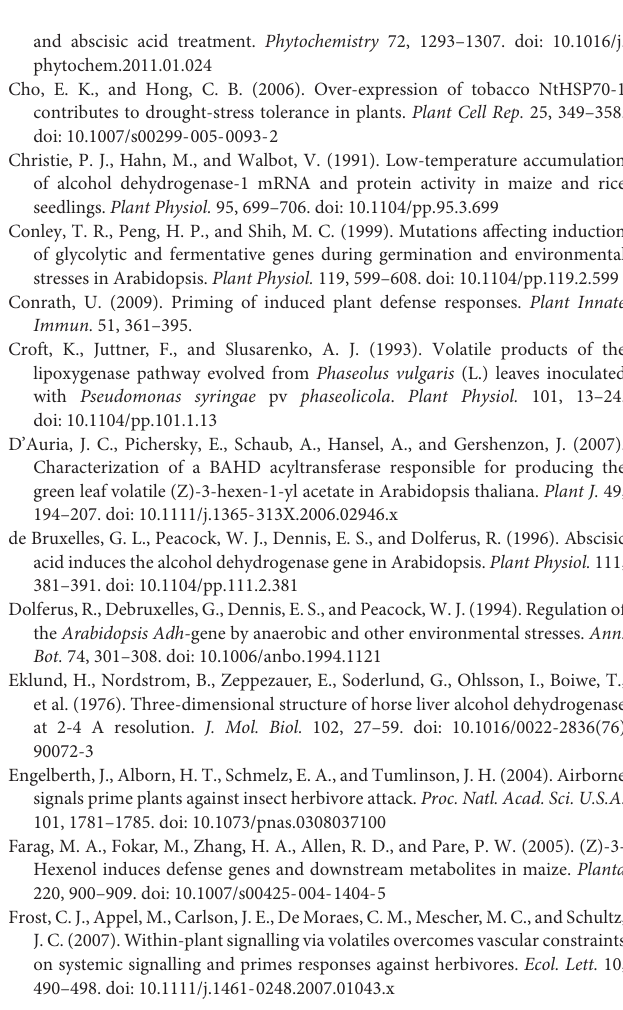
FIGURE S1 | Alignment of Synechocystis sp. PCC 6906 (Sysr1), Synechocystis sp. PCC 6803 (AdhA), and horse liver (LADH) ADH sequences. Residues shared